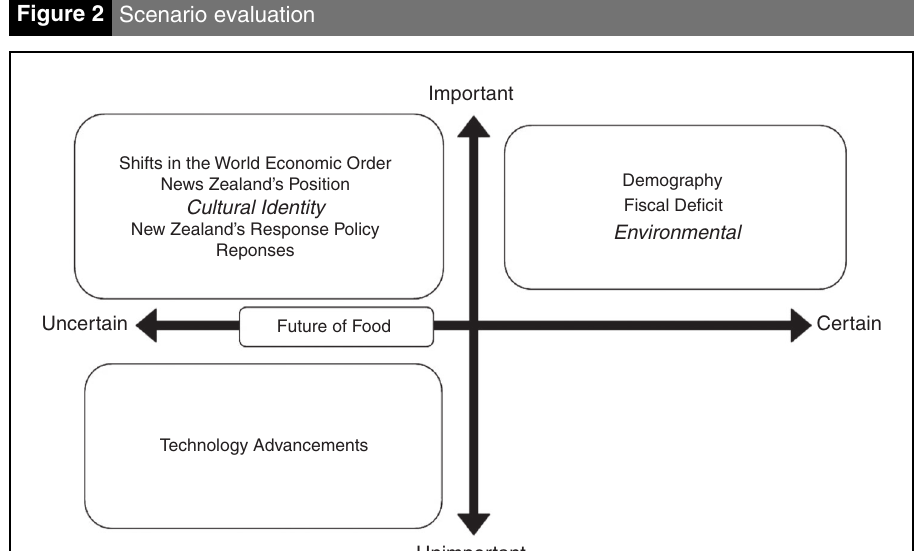
Figure 2 Scenario